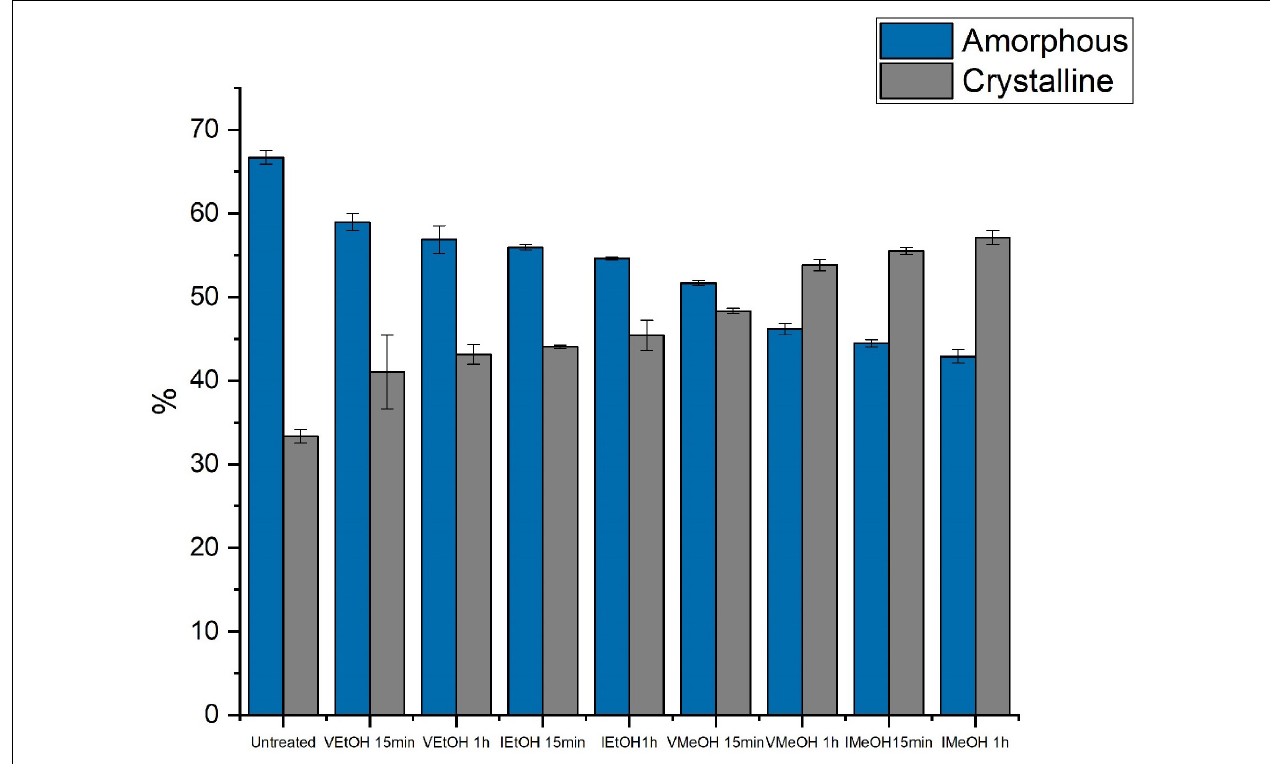
FIGURE 5 | FTIR amorphous and crystalline structures of treated and untreated SFW films.